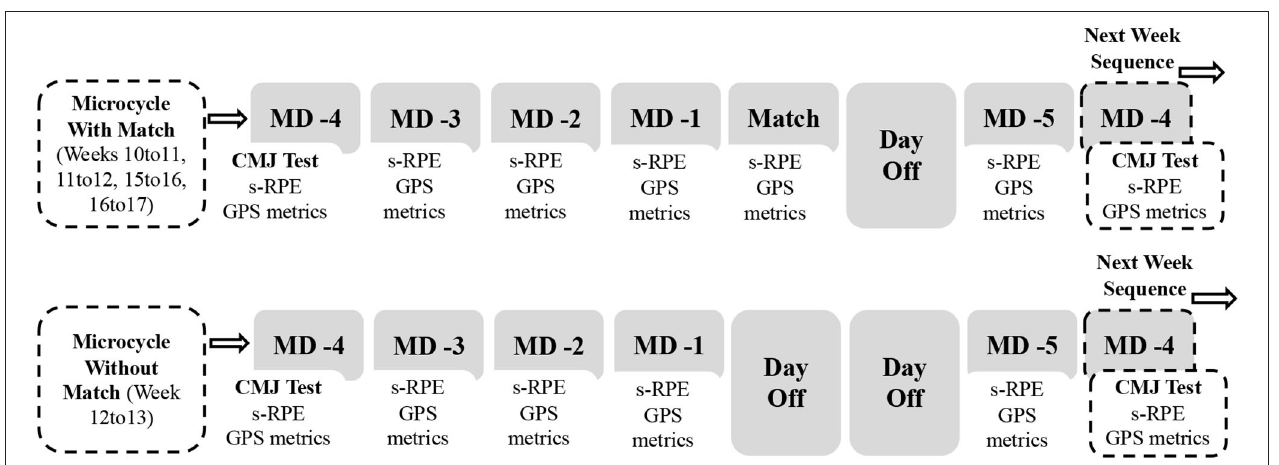
FIGURE 1 | Representation of a weekly data collection